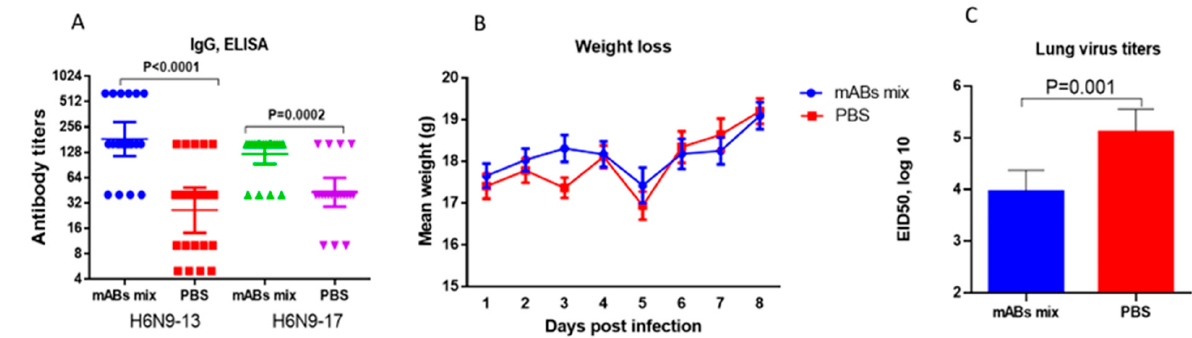
Figure 8. Results of mABs to N9 assessment in mice. ( A ) Serum IgG levels 5 h after immunization with mABs mix. The summary data of two experiments are presented ( n = 20). ( B ) Changes in weight after intranasal infection with 300 MID 50 of the A/Guangdong/17SF003/2016 IDCDC-RG56N(H7N9) influenza virus ( n = 10). Mean values and standard error are presented. Data from one of two independent experiments are presented. ( C ) Reproduction of an infectious virus in the lungs on the fifth day after infection ( n = 8). The data of two experiments are